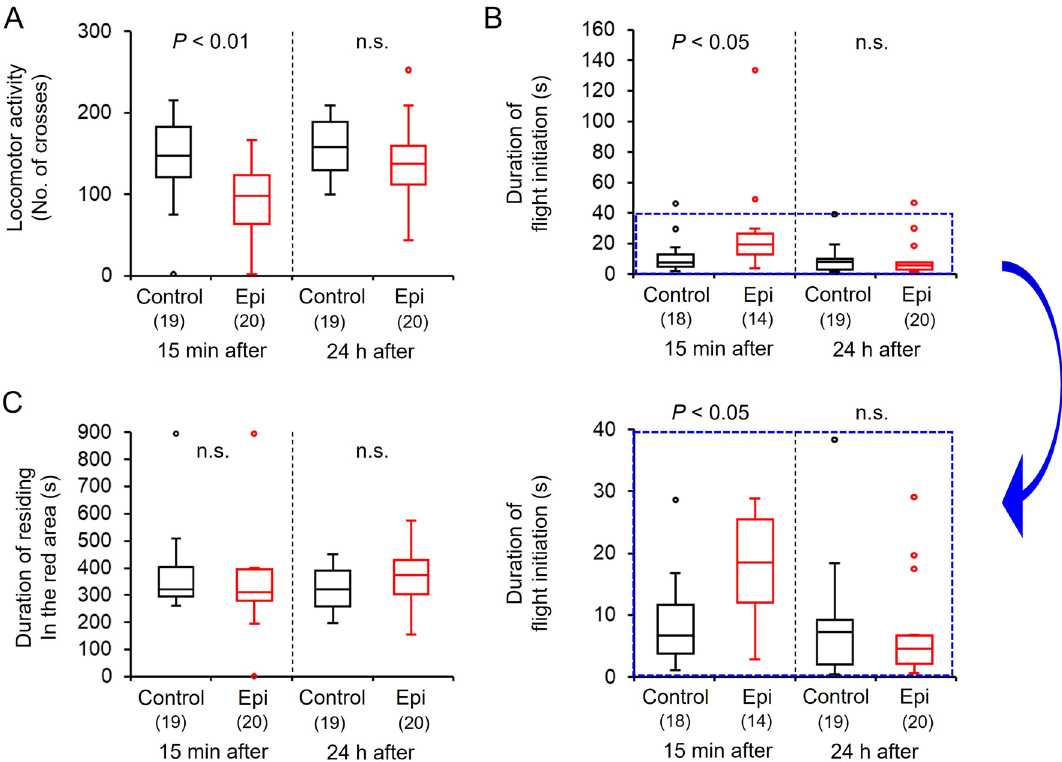
Figure 6. Effects of epinastine (octopamine receptor antagonist) injection on behavioral activities of 4-day-old males in the bumble bee: ( A ) spontaneous locomotor activity, ( B ) duration of flight initiation, ( C ) duration of time residing in the red area as a light preference index. Locomotor activity, duration of initiation, and duration of residing in the red area are indicated by box plots. Significant differences between the epinastine-treated and control groups were evaluated using the Mann–Whitney U-test. Durations of flight initiation are magnified in the boxes (blue dashed border). Numbers in bars indicate sample